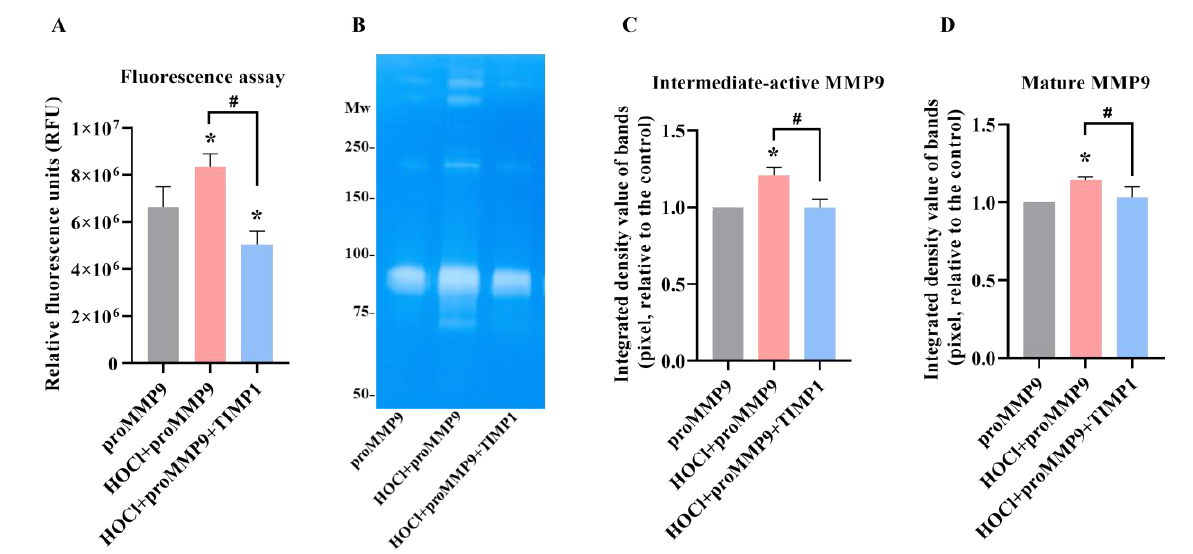
Figure 4. Fluorescence activity and zymographic detection of proMMP9 exposed to HOCl and, subsequently, TIMP1. ( A ) ProMMP9 (13 nM) was incubated with a 385-fold molar excess of reagent HOCl (5 µM) for 2 h at 37 °C, at pH 7.4, in buffer, and then incubated with a 10-fold molar excess of TIMP1 (over proMMP9) for a further 1 h before the assay of activity using either the fluorescence- activity assay (see legends to Figures 1 and 3 for further details) or ( B ) zymography. The data in Panel A are presented as relative fluorescence units and are the means ± SDs of three technical replicates from three biological replicates. ( C , D ) Integrated density value of the bands from Panel B were analyzed using ImageJ software and are expressed as means ± SDs from three independent experiments. Statistical analysis was performed using one-way ANOVA with Dunnett’s multiple comparisons test. Statistical significance at the p < 0.05 level when compared to the nontreated group is indicated by *. Statistical significance of the TIMP1-treated samples compared with the HOCl- treated proMMP9 is indicated by #.